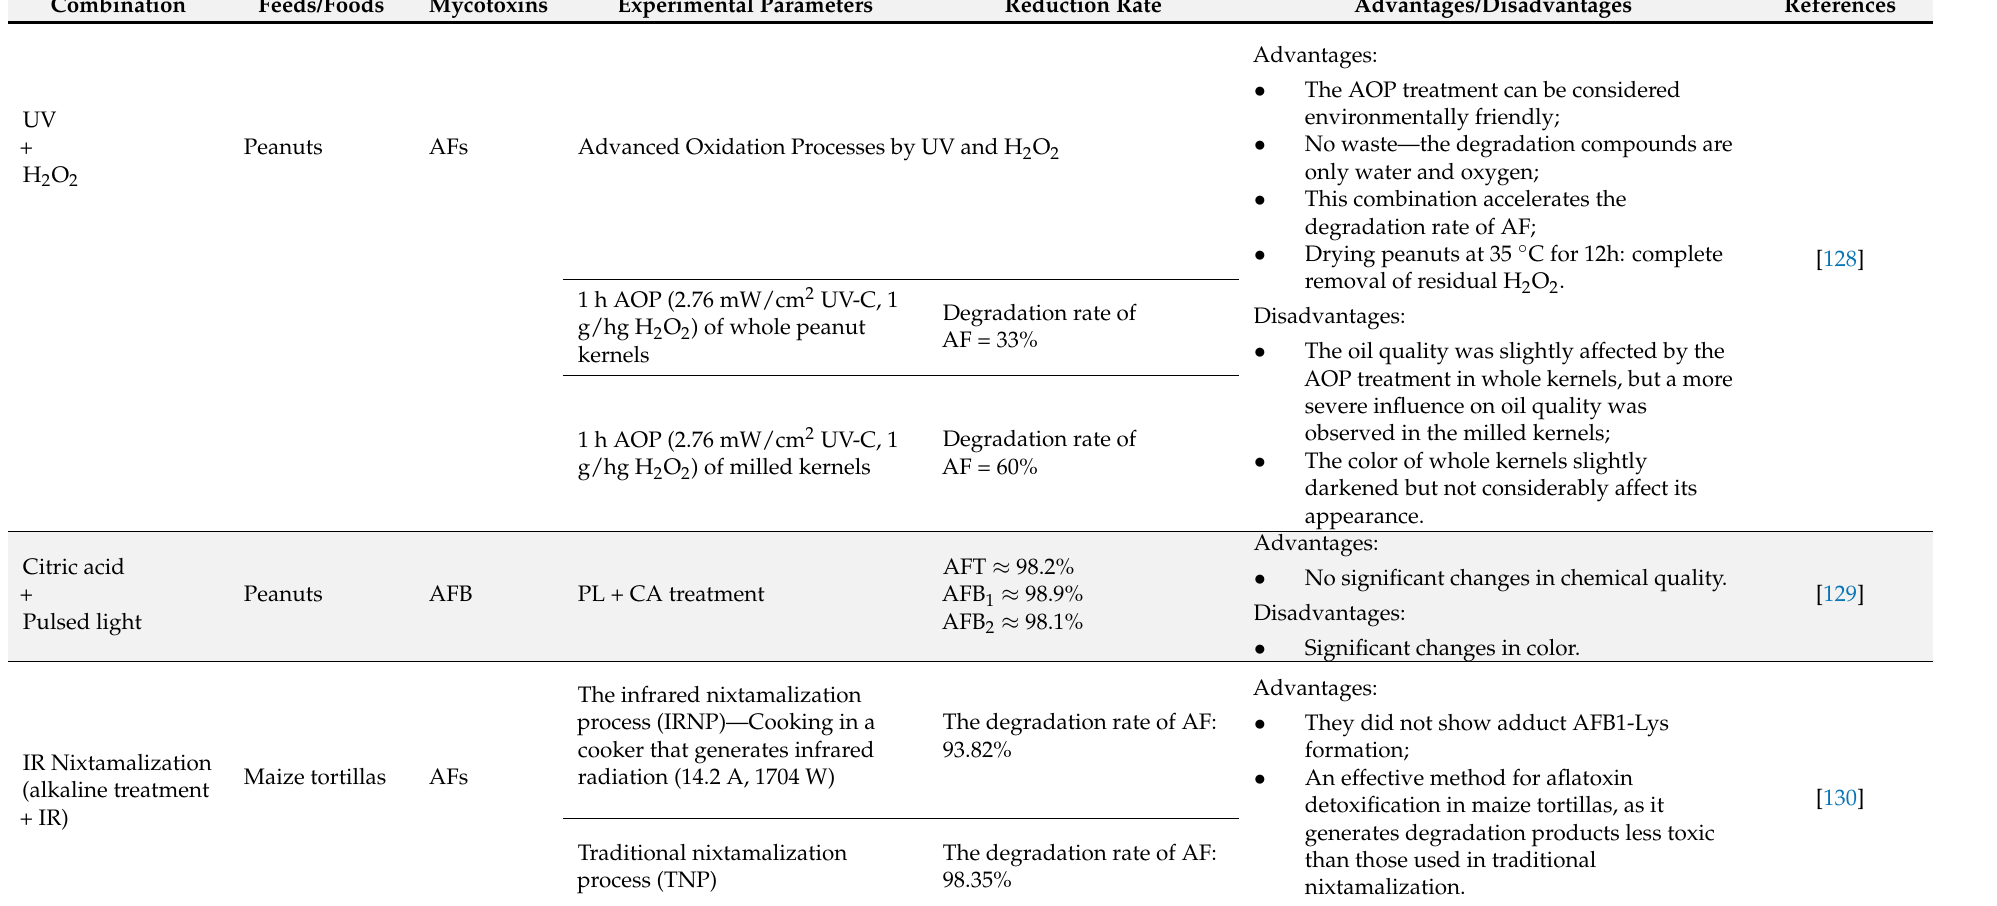
Table 5. Simultaneous techniques to mitigate mycotoxins in solid foods and